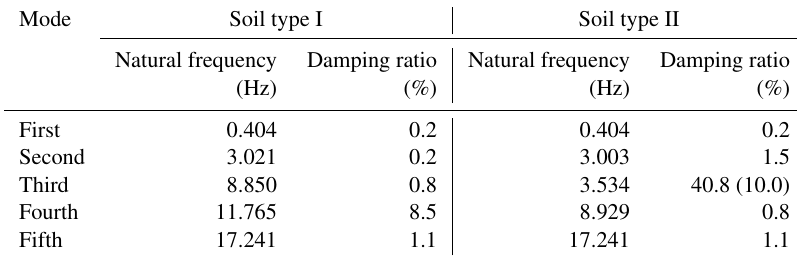
Table 5. Modal properties of the 2MW wind turbine support structures.